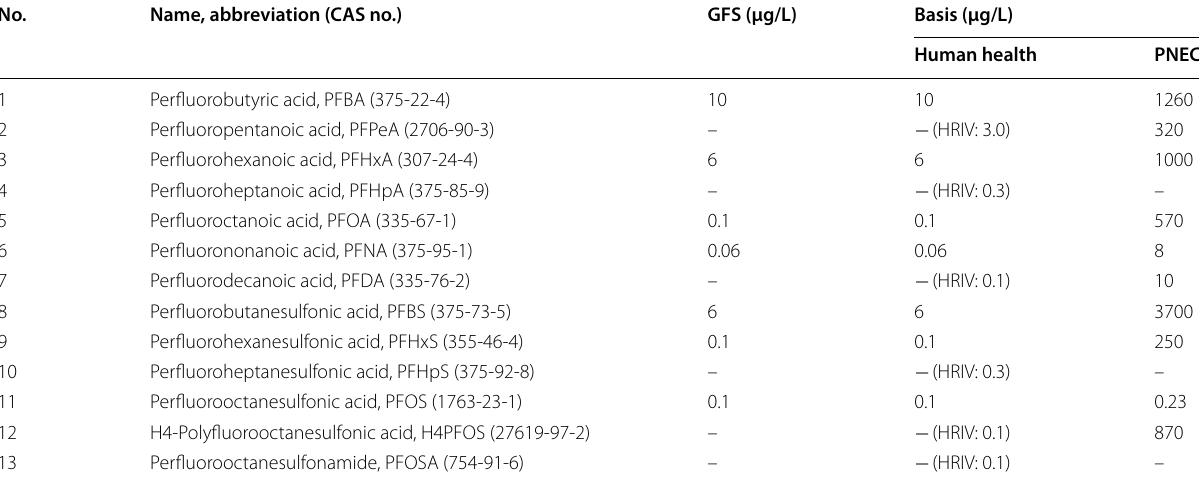
The HRIV for non-assessable substances is explained in sections “Substances insufficiently characterized” and “Uncertainty analysis” as well as in LAWA [62]